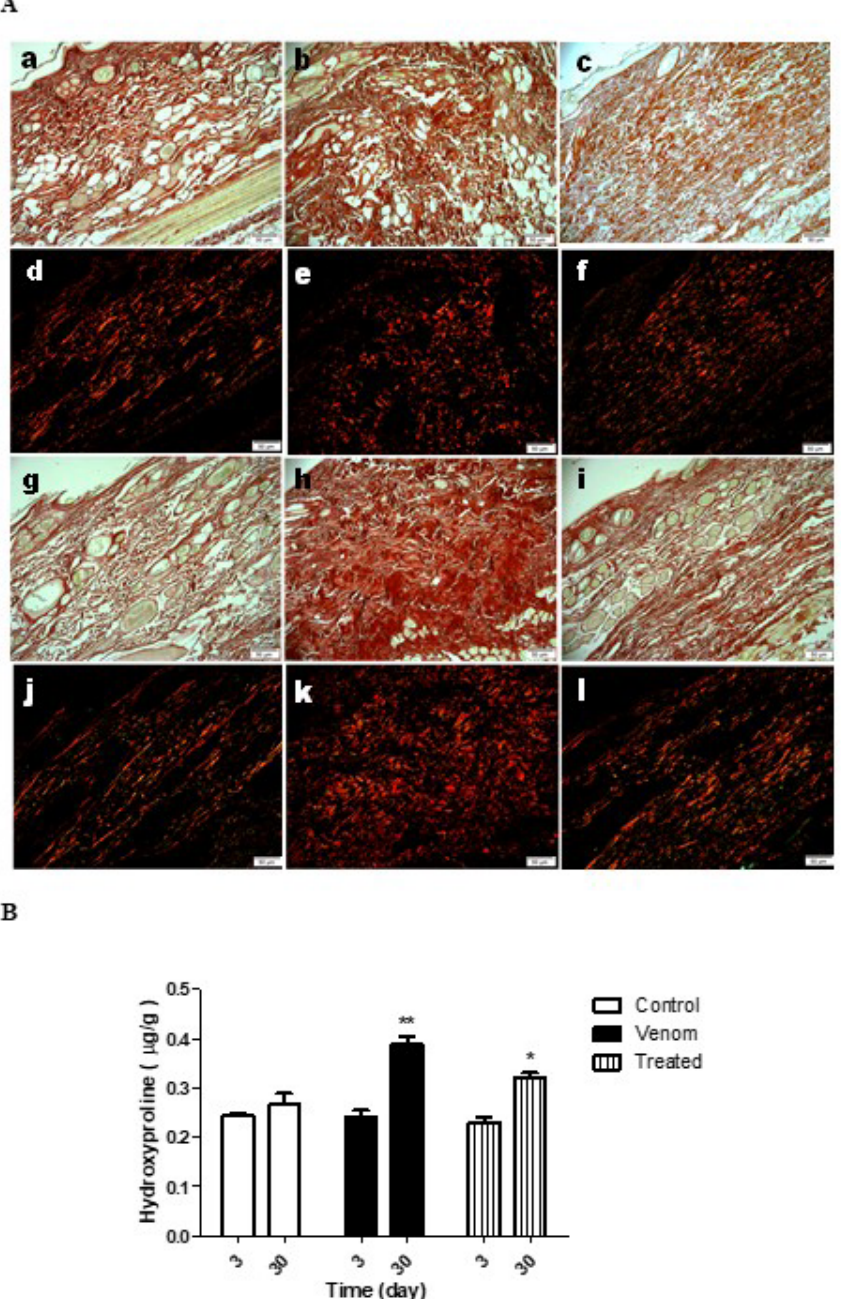
Figure 4. Photomicrographs of collagen on skin of rabbits 3 and 30 days after inoculation of L. intermedia venom in the back. Picrosirius red staining under optical light reveals total collagen as red, polarized light collagen type I as red fibers and collagen type III as green fibers. The control animals presented normal distribution of collagen types on the skin at 3 ( a - a/d) and 30 days ( a - g/j), and did not differ in total collagen quantification by hydroxyproline ( b ). The animals inoculated with venom at 4.8 µg/kg did not differ at day 3 post-inoculation compared to the control group ( a - b/e) but showed increase of collagen deposition at 30 days ( a - h/k), quantified by hydroxyproline ( b *p<0.001 / ANOVA). The animal group inoculated with venom and treated with copaiba oil showed no difference at day 3 ( a - c/f), but at 30 days presented less intense increase of collagen ( a - i/l), quantified by hydroxyproline ( b *p<0.05 / ANOVA). n = 4 animals per experimental